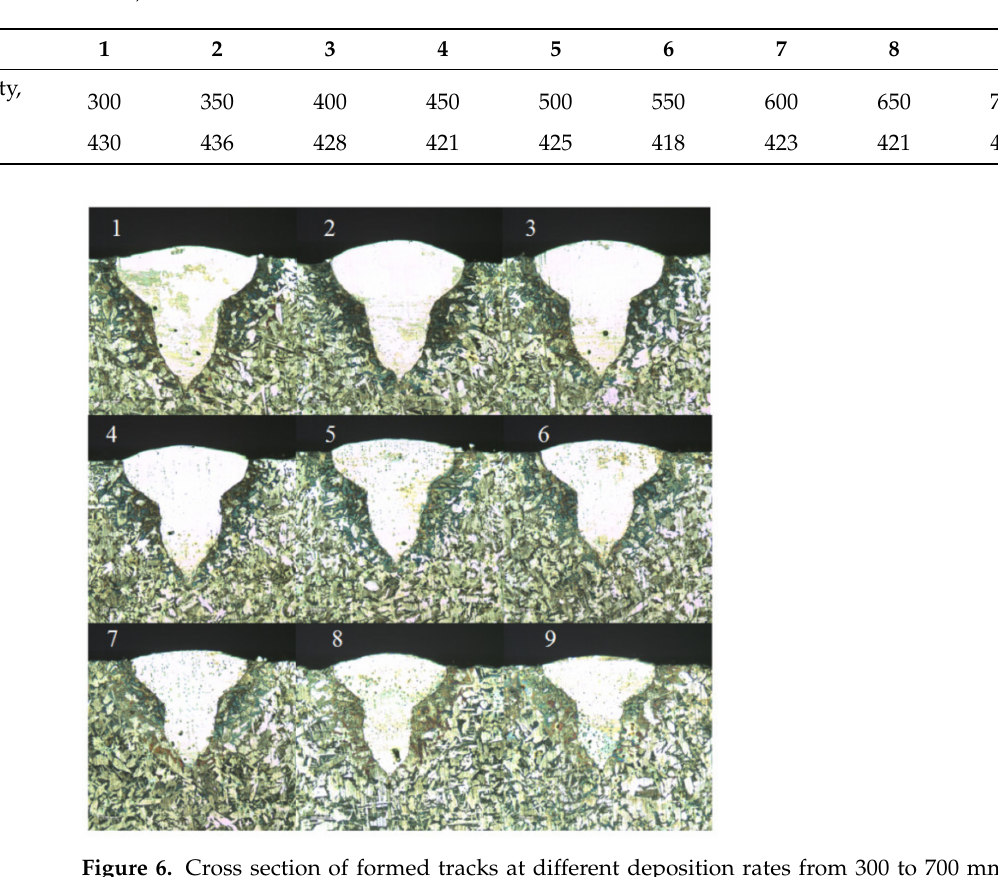
Figure 6. Cross section of formed tracks at different deposition rates from 300 to 700 mm/min, P = 400